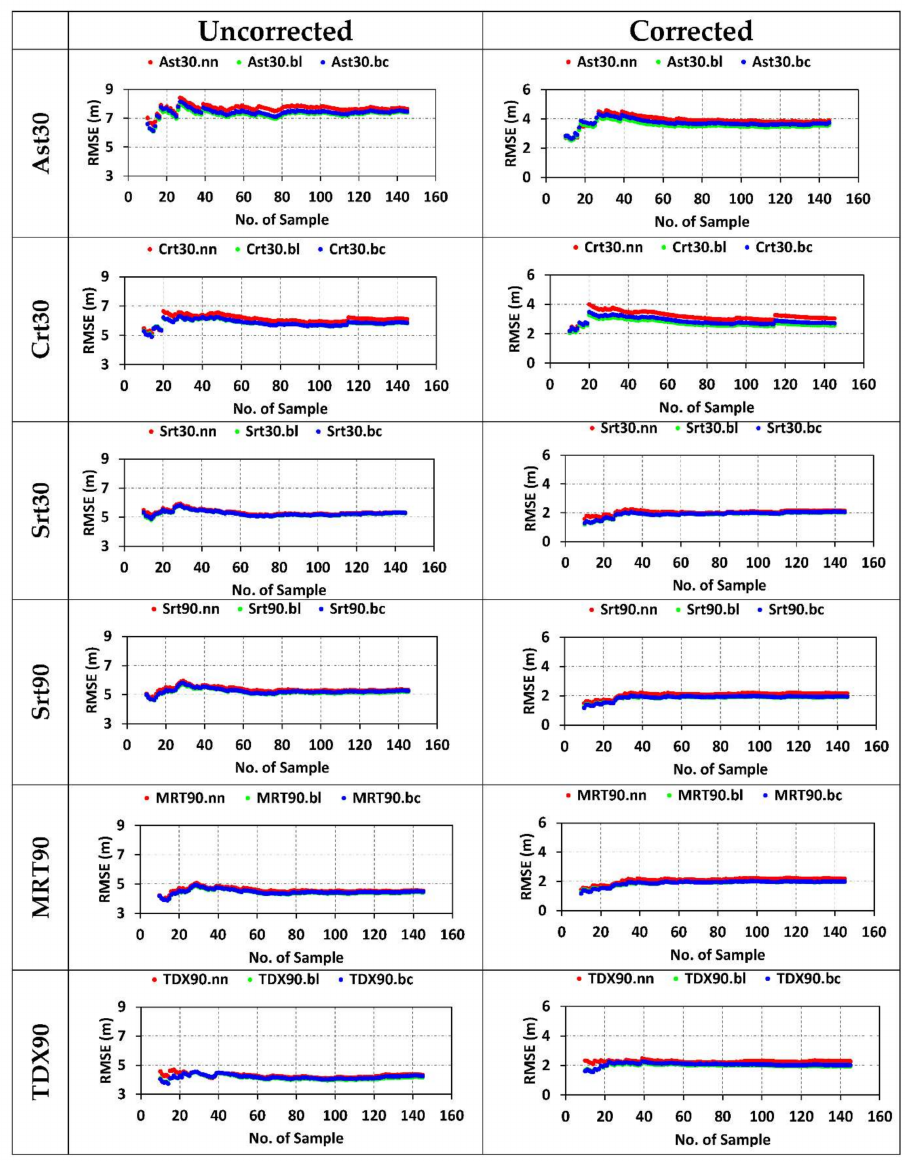
Figure 5. The variation in the calculated values of root mean squared error (RMSE) with increasing number of GCPs (randomly selected) exhibits a drop in the RMSE to up to approximately 40–60 GCPs (Ast30, Srt30) and, thereafter, remains nearly invariable (for 60–145 no. of GCPs). There is a sharp reduction in RMSE for corrected space-borne elevation datasets (ASTER and SRTM). The nn, bl, and bc refer to the interpolation methods. (Ast30 = ASTER GDEM V3, Crt30 = CartoDEM v3.R1, Srt30 = SRTM.v3, Srt90 = SRTM.v4.1, MRT90 = MERIT DEM, TDX90 = TanDEM-X